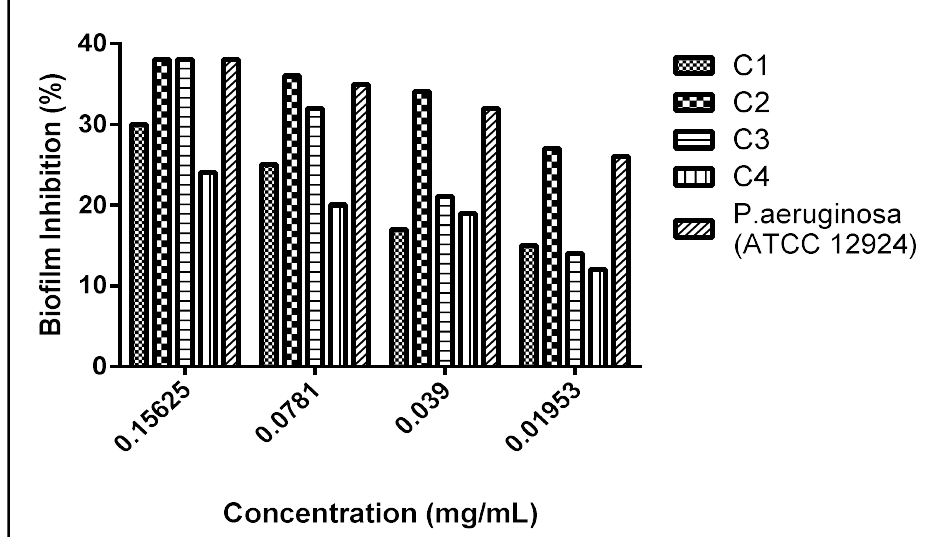
Figure 5. Biofilm formation inhibition activities of L. coronopifolia extract against P. aeruginosa